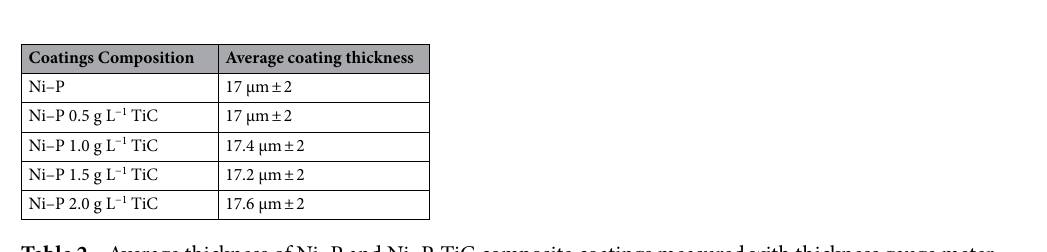
Table 2. Average thickness of Ni–P and Ni–P-TiC composite coatings measured with thickness gauge meter.